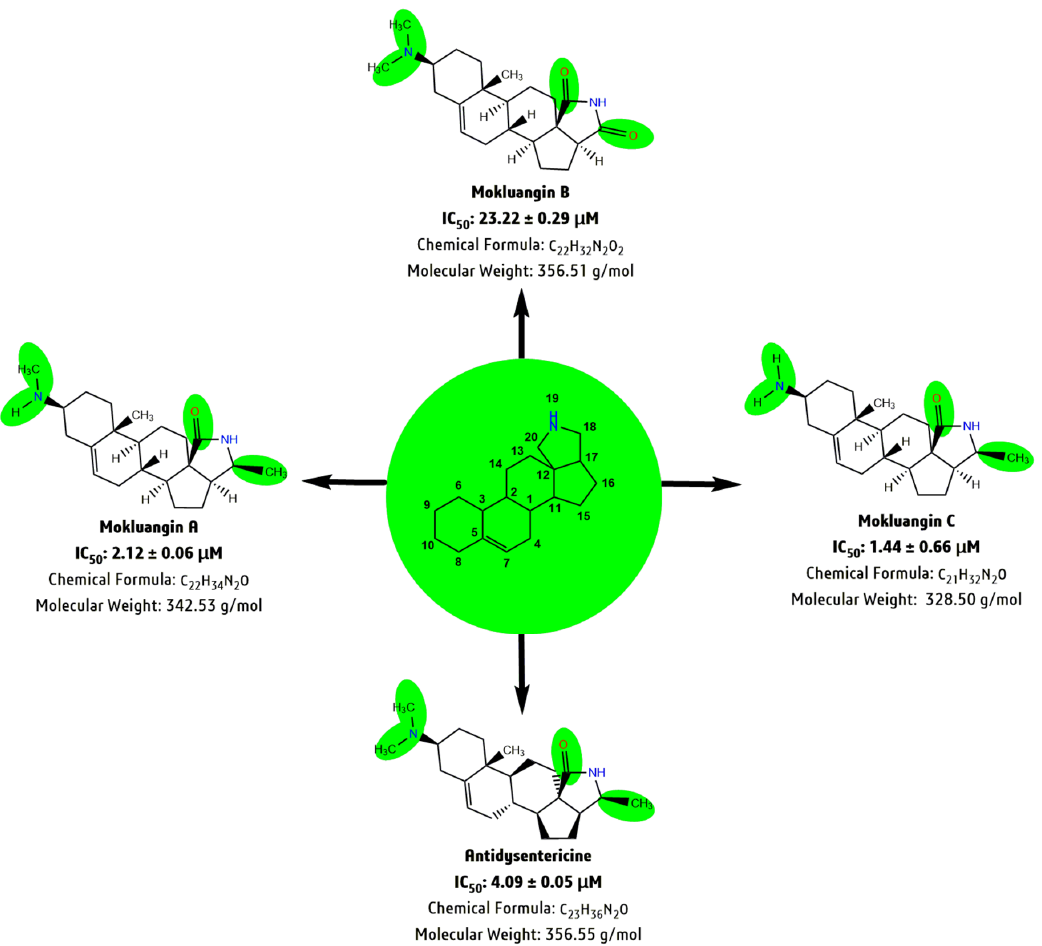
Figure 4. Schematic representation of the Structural-Activity-Relationship (SAR) of the steroid-alkaloid class of phytoconstituents; Mokluangin A-C and antidysentericine, isolated from H. pubescens . IC 50 expressed in μ M, range of 1.44 to 23.22 for acetylcholinesterase activity.